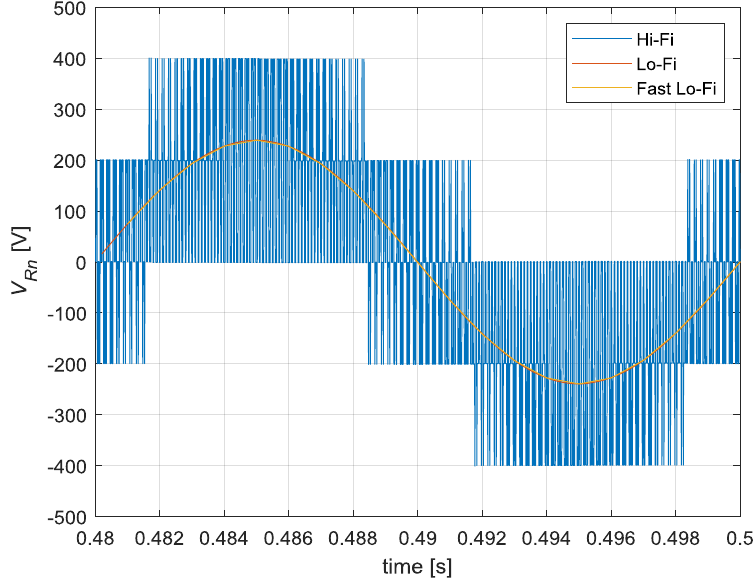
Figure 24. Comparison of the Hi-Fi, Lo-Fi, and Fast Lo-Fi output